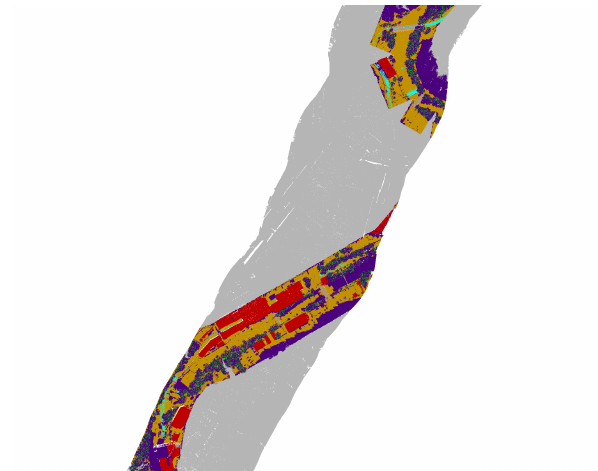
Figure 6. GT for assigned labels.